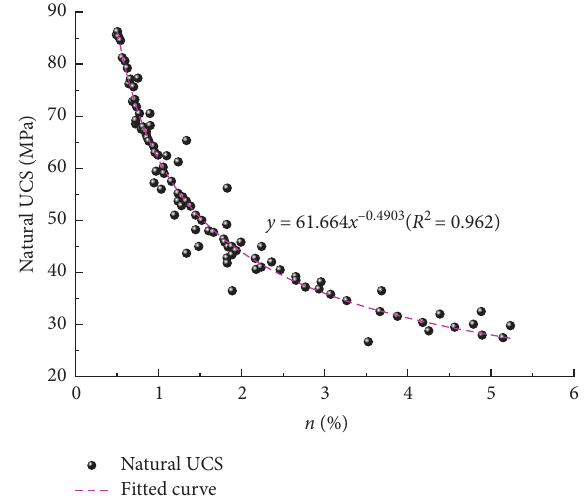
Figure 3: The fitted curves of the natural UCS and the porosity ( n � 0.5% ∼